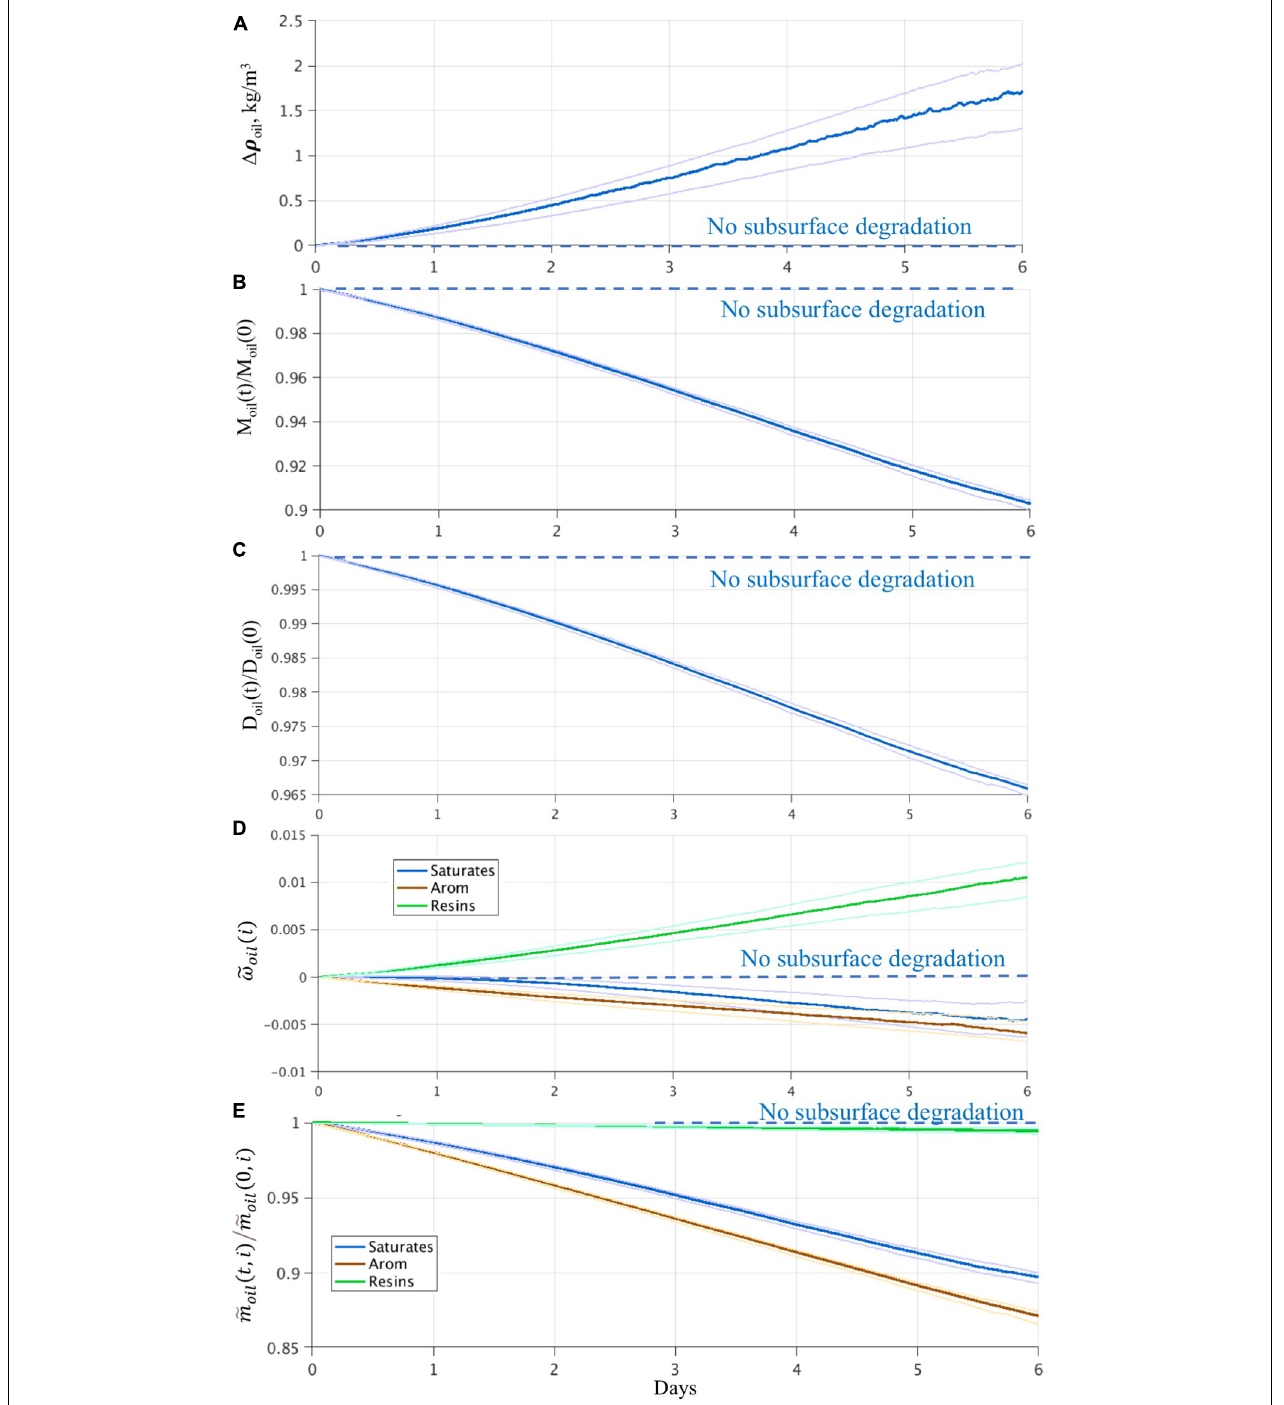
FIGURE 8 | Statistics of changes in oil characteristics in the experiments using LEM and ELM with and without subsurface biodegradation from a coupled ROMS-OTWM-Biogeochemical model. (A) Change of oil droplet density (kg m − 3 ). (B) Reduction of the oil droplet mass relative to the original mass. (D) Reduction of the oil droplet size relative to the initial size. (C) Weight fraction of oil compounds. (E) Reduction of mass of oil compounds. The estimates are obtained from all floats over the first 6 days after the floats are released at the bottom and until they reach the surface. The solid line is the median, the lighter lines are the inter-quartile range. The horizontal dashed line indicates no change in oil characteristics in the experiment without subsurface degradation. The change in oil characteristics due to biodegradation demonstrates the impact of biogeochemical model coupling using LEM and ELM. The horizontal axis is subsurface time (days) of oil particles from the release until particles reach the